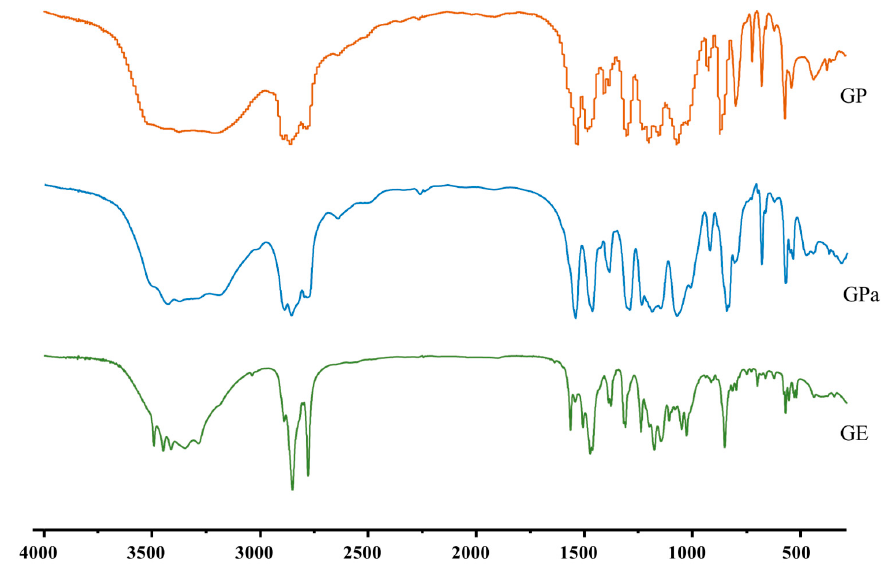
Figure 3. FT-IR spectrum of GP, GPa and GE. The molecular weight of GP, GPa, and GE were further investigated using MS (Figure 4). The corresponding ESI—MS spectrum (negative ion mode) of each